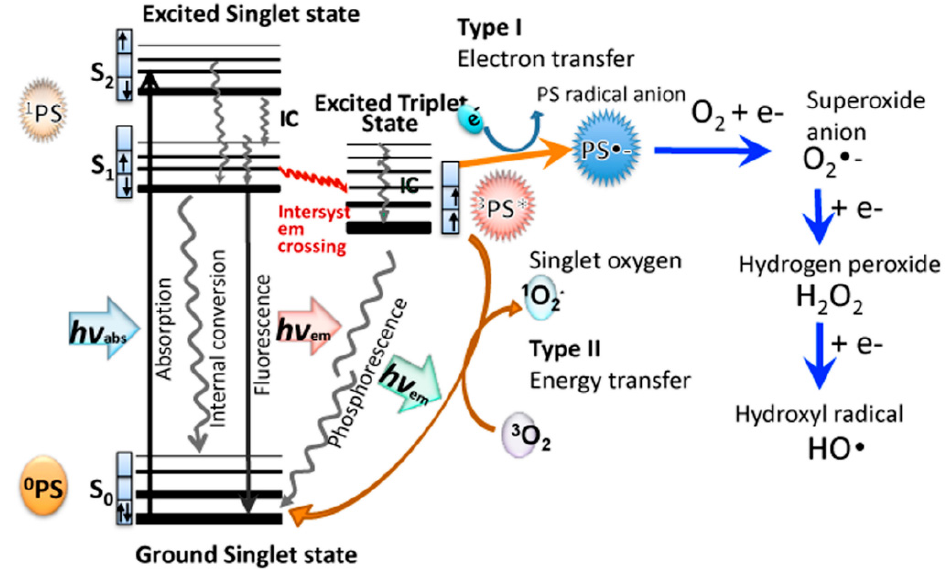
Figure 5. Jablonski diagram [23].